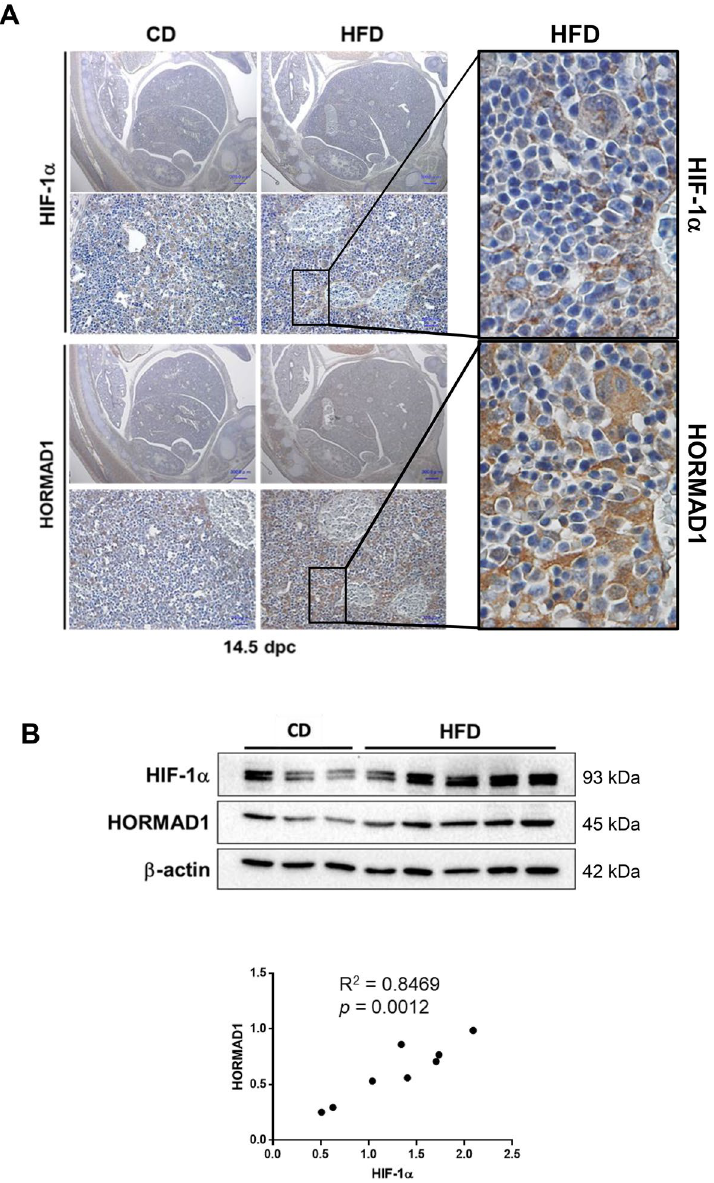
Figure 3. HORMAD1 colocalizes with HIF-1α in fetal livers. ( A ) Representative photomicrographs of immunohistochemical staining for HIF-1α and HORMAD1 in fetal livers at 14.5 dpc. Scale bars: 300 μm (low magnification) and 30 μm (high magnification). Insets show the magnified images from the left panels. ( B ) Western blot analysis showed positive correlations between HORMAD1 and HIF-1α levels in the fetal livers of mice (R 2 = 0.8469, p = 0.0012). ( C ) Immunohistochemical staining for HIF-1α and HORMAD1 in the livers of offspring at 15 weeks of age. Scale bars: 300 μm (low magnification) and 30 μm (high magnification). Quantification of HORMAD1-positive area (CD = 8 offspring from 3 dams, HFD = 7 offspring from 3 dams). ** p < 0.01 using the Mann–Whitney test. ( D ) Western blot analysis of HIF-1α and HORMAD1 levels in the livers of 15-week-old offspring. MWM: 117 kDa band in the molecular weight marker (HiMark Prestained protein standard, Thermo Fisher Scientific). ( E ) Macroscopic image of the liver after barium perfusion of offspring from HFD-fed dams at 33 weeks old. ( F ) Visualization of 3D vessels in the liver of offspring from HFD-fed dams at 33 weeks old using synchrotron micro-CT and Amira software (version 1.4.0, https:// www. therm ofish er. com). ( G ) Immunohistochemical staining for HIF-1α and HORMAD1 in hepatic tumors from 33-week-old offspring of HFD-fed dams. Insets in the middle panels show the magnified images (right panels). HORMAD1 expression in peritumoral lesions (dotted line) and intratumoral lesions (double lines) in hepatic tumors from 33-week-old offspring of HFD-fed dams. Insets in the left panels show the magnified image of each lesion. ( H ) Capsular invasion of a hepatic tumor. Arrows show the area of invasion. Bars: 300 μm (low magnification) and 30 μm (high